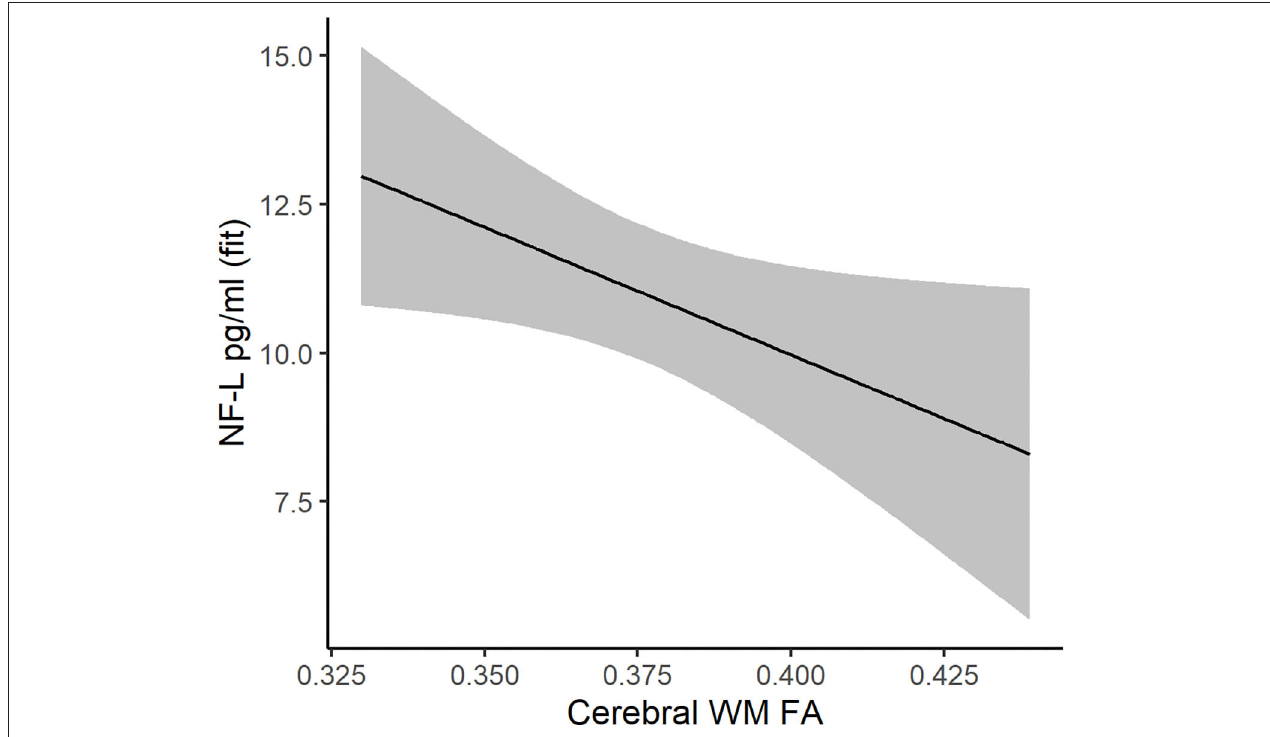
FIGURE 4 | Association between cerebral white matter FA (x-axis) and NF-L (y-axis) in DM1 patients. The regression line and 95% confidence limits were derived from a mixed linear model that also included age at evaluation, sex, and random intercepts and slopes for age at